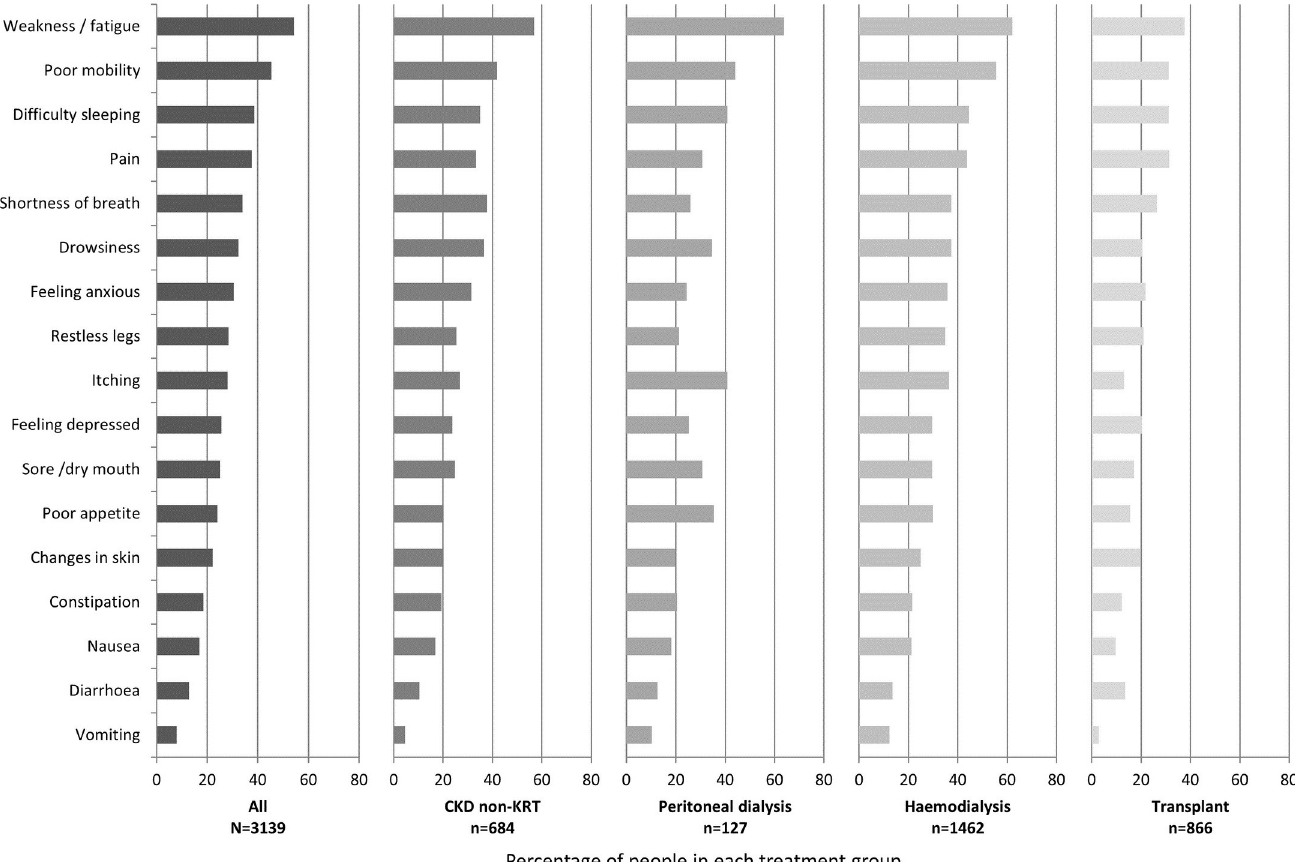
Fig 1. Prevalence of individual symptoms, presented by treatment group; people were considered to have the symptom if they had a score of > 1 on the POS-S Renal (i.e. reported being at least slightly bothered by a symptom).